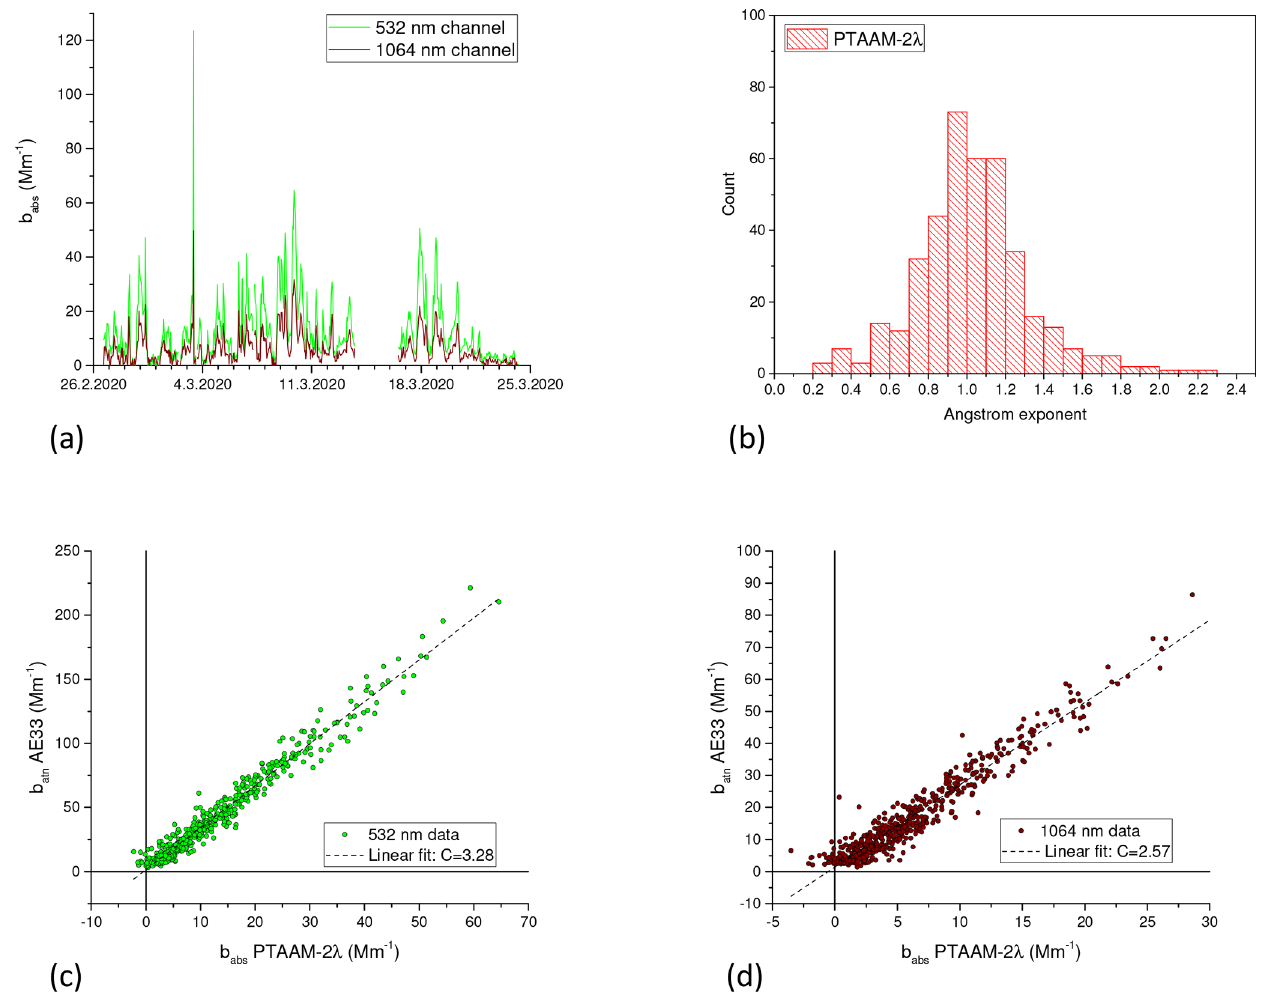
Figure 16. Absorption coefficient measured during the Ljubljana 2020 winter campaign (a) and a frequency distribution of the Ångström exponent (b) . Correlations between attenuation coefficient and absorption coefficient for the 532nm channel (c) and the 1064nm channel (d) .